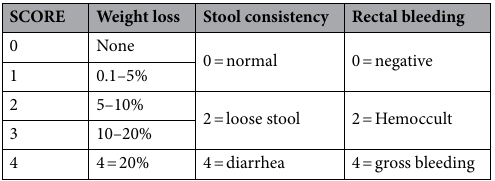
Table 3. Scoring of disease activity index